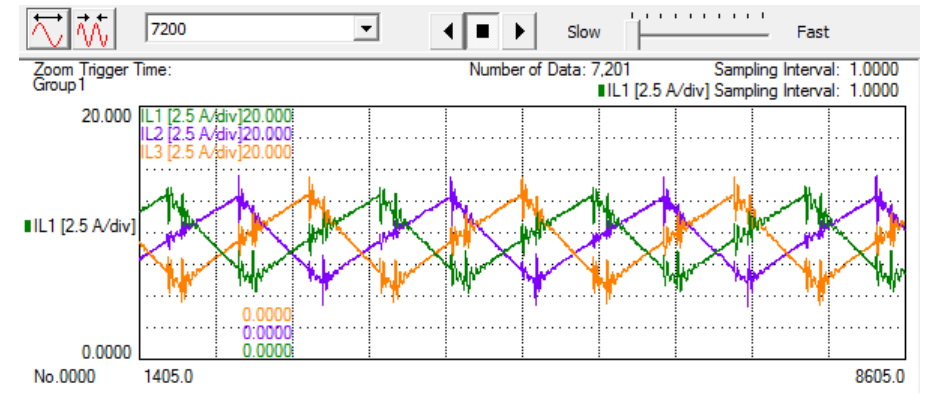
Figure 23. Steady-state phase